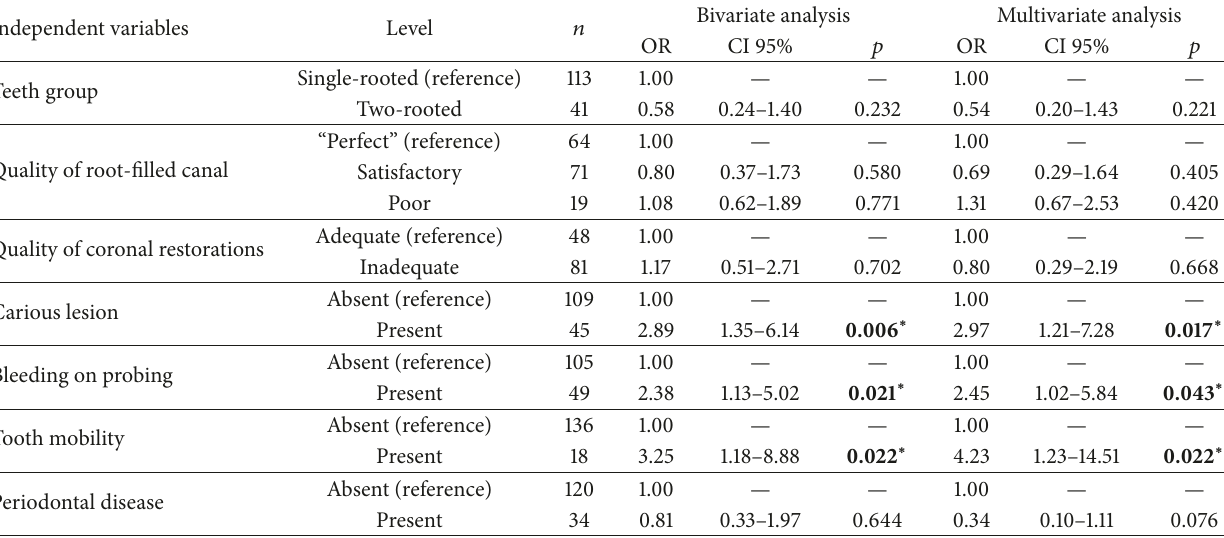
Table 6: Bivariate and multivariate logistic regression between independent variables and treatment failure ( 𝑛 = 154). Independent